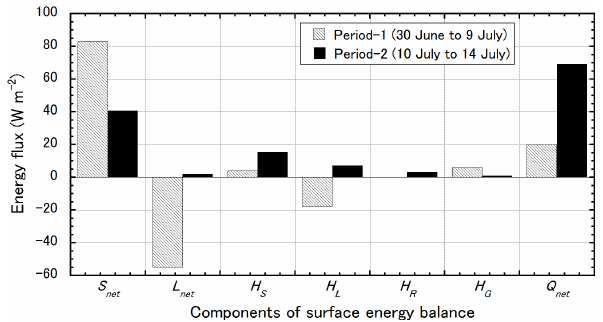
Figure 11. Comparison of average surface energy balance compo- nents ( S net is net shortwave radiant flux, L net is net long-wave radi- ant flux, H S is sensible heat flux, H L is latent heat flux, H R is heat supply by rainfall, H G is subsurface conductive heat flux, and Q net is net energy flux) between Period-1 and Period-2 at the SIGMA-A